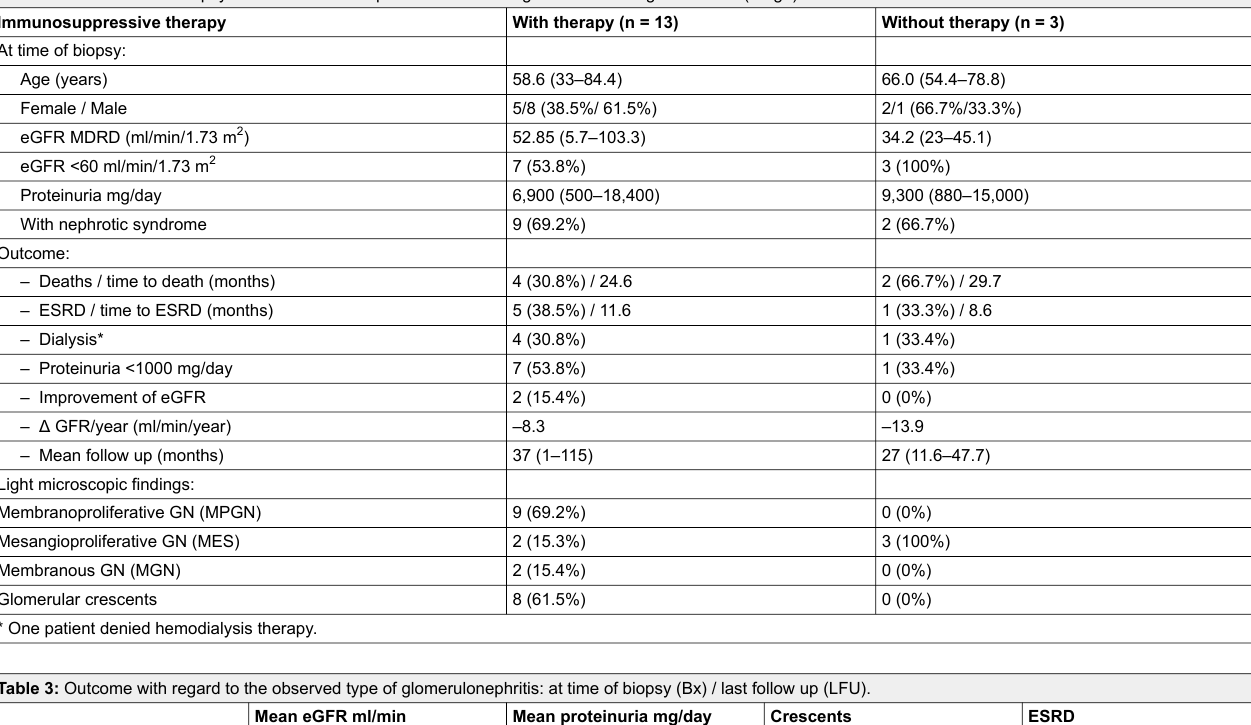
Table 2: Data at time of biopsy and on last follow up stratified according to treatment regimen mean (range). Immunosuppressive therapy With therapy (n = 13)